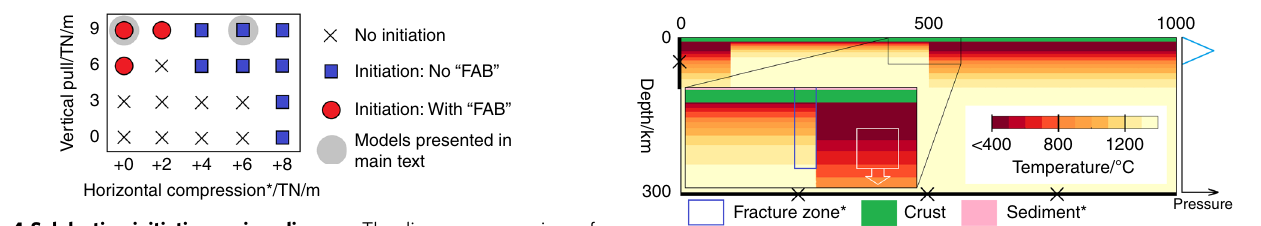
Fig. 4 Subduction-initiation regime diagram. The diagram summarises of all the models run during this study. The magnitudes of the vertical pull force, applied to the Paci fi c plate, and the external horizontal push force were varied. *Horizontal compression beyond what is needed to balance the initial, internally generated horizontal forces (see section S3). The two models described in more detail in the main text are highlighted with a grey circle.